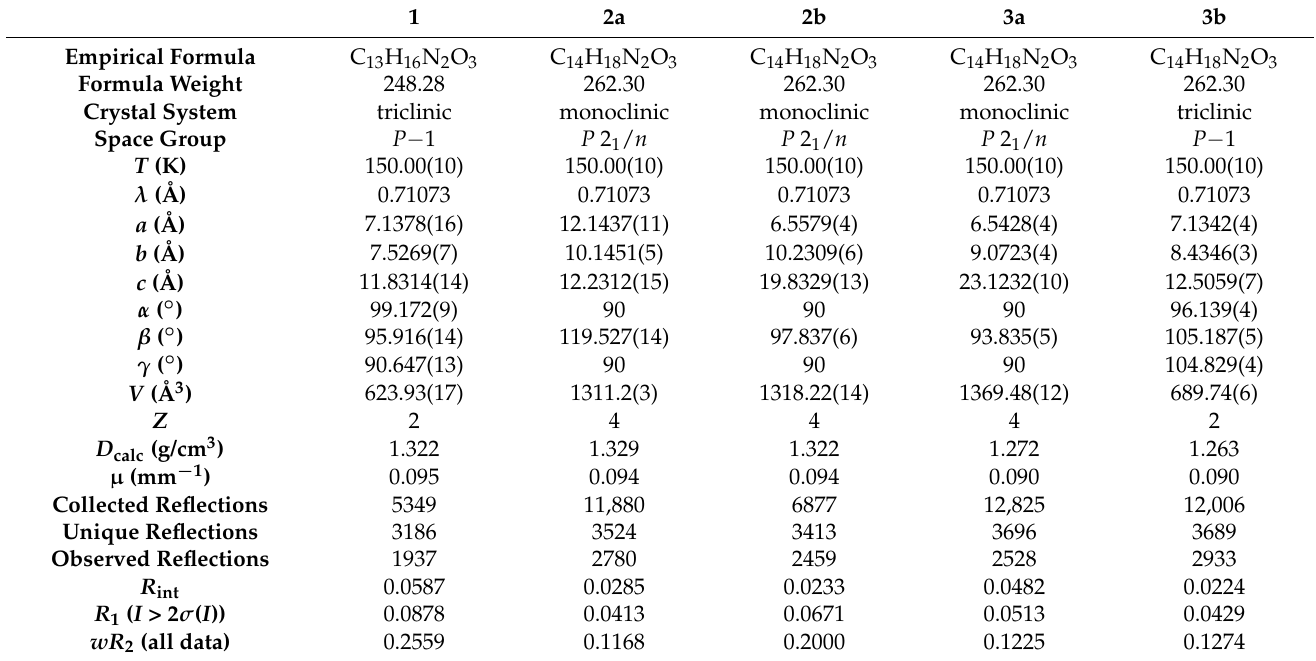
Table 4. Crystallographic data for 1 – 3b